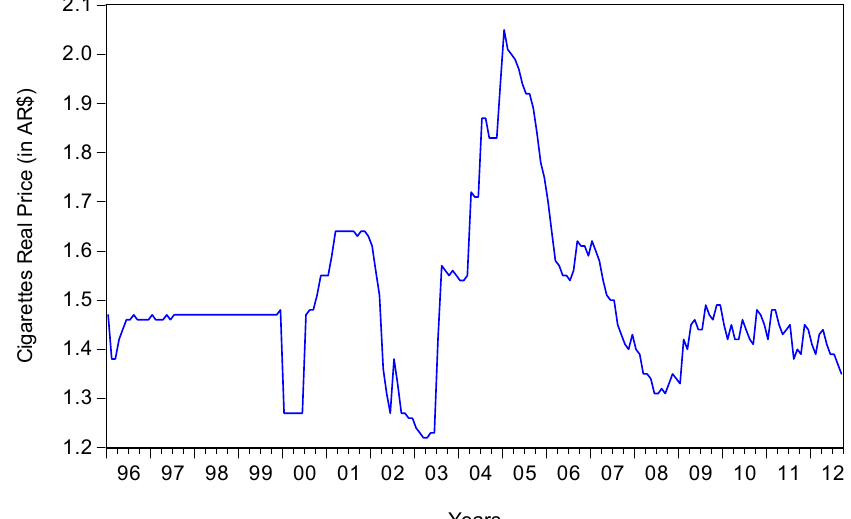
Figure 3. Real price of a pack of 20 cigarettes. Source: Authors’ calculations. CPI April 2008 = 100.